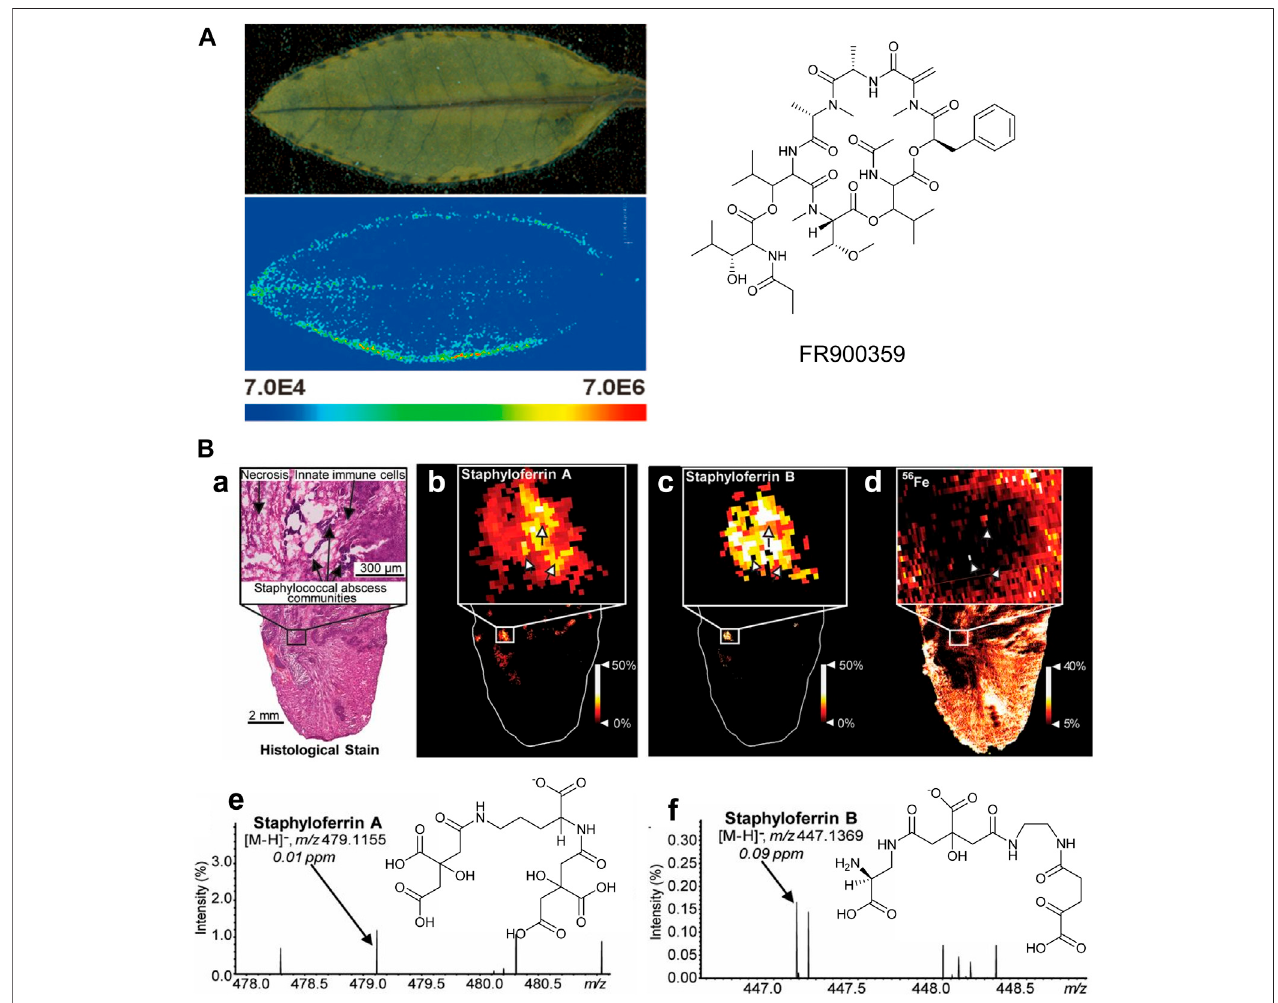
FIGURE 9 | (A) MALDI imaging mass spectrometry of an Ardisia crenata leaf (Cruesemann et al., 2018). (B) MALDI-IMS reveals siderophores staphyloferrin A (SA) and staphyloferrin B (SB) within the infectious environment. (a – d) The distributions of SA and SB with SACs. (e-f) The signals and the chemical structures of SA, [M-H] − and SB, [M-H] − (Perry et al.,